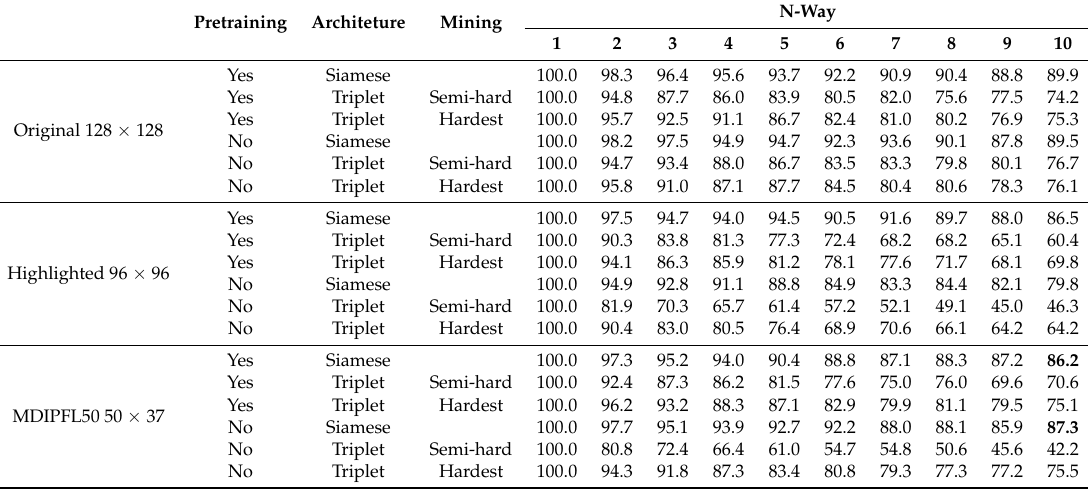
Table 1. The performance of each method for metric learning on the NIST dataset, given by the one-shot classification accuracy on the validation subsets. 1000 classification tasks were evaluated for each measurement.